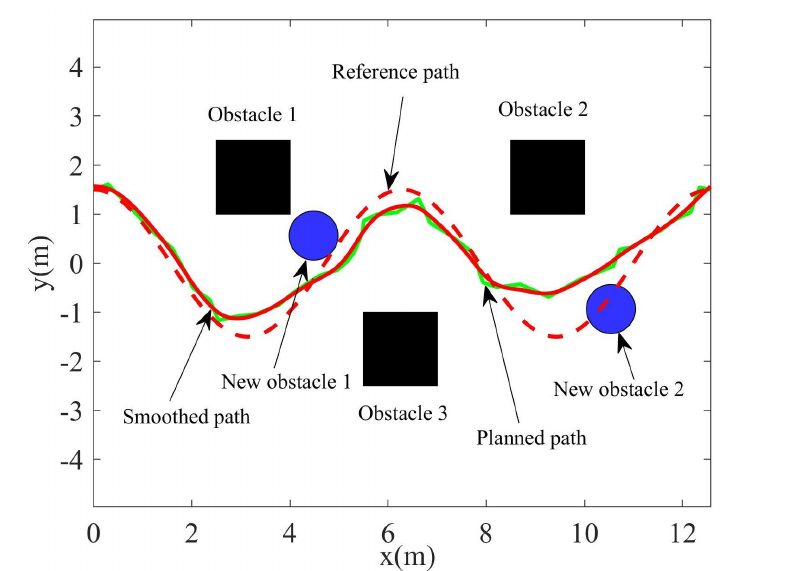
Figure 7. Path planned by the